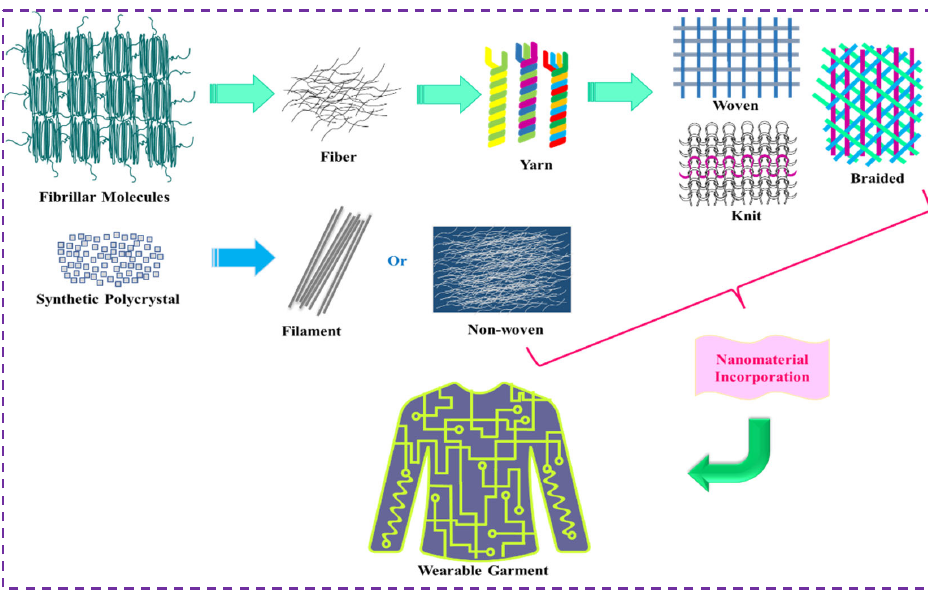
Figure 1. Hierarchy of textile structures.